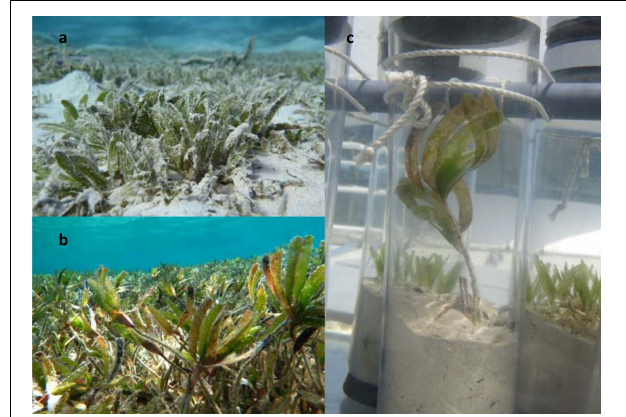
FIGURE 2 | Seagrass meadows of Halophila stipulacea (a) and Thalassodendron ciliatum (b) in the Red Sea. Close-up picture of the hermetically closed cores submerged in the incubation chambers (c) . Photo credit: A.